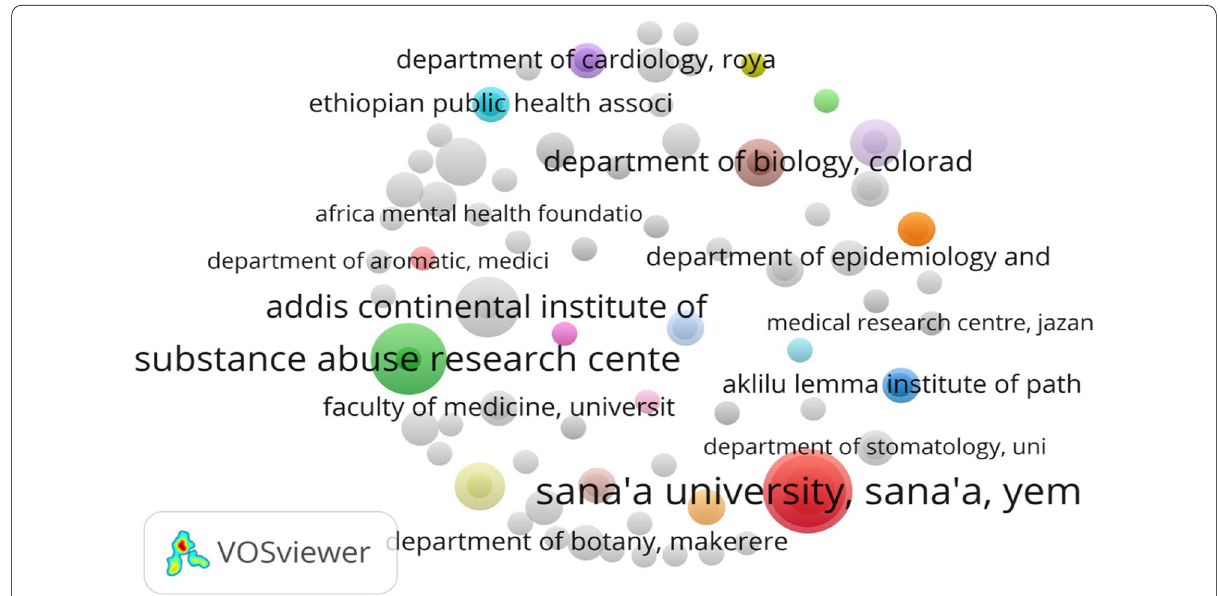
Fig. 9 Mapping of organizations according to